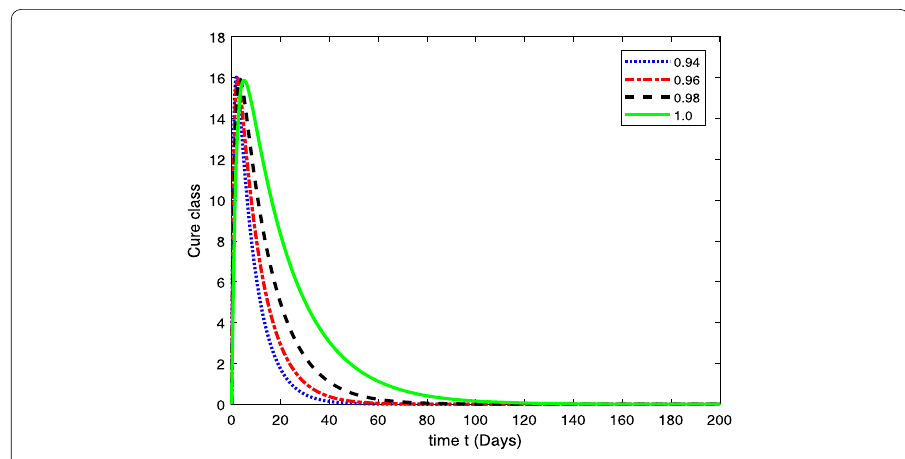
Figure 2 The cured class C ( t ) for α 1 = 1,0.98,0.96,0.94 and h = 0.09